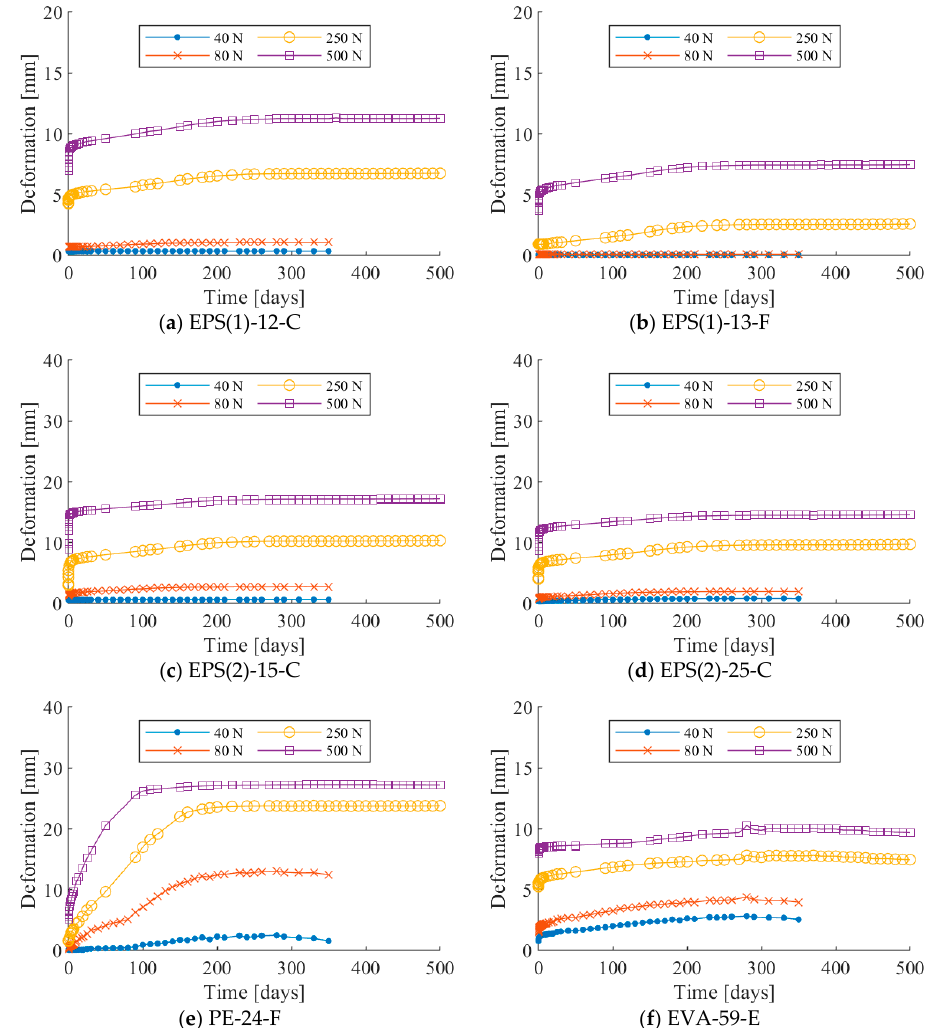
Figure 5. Long-term compressive deformation.